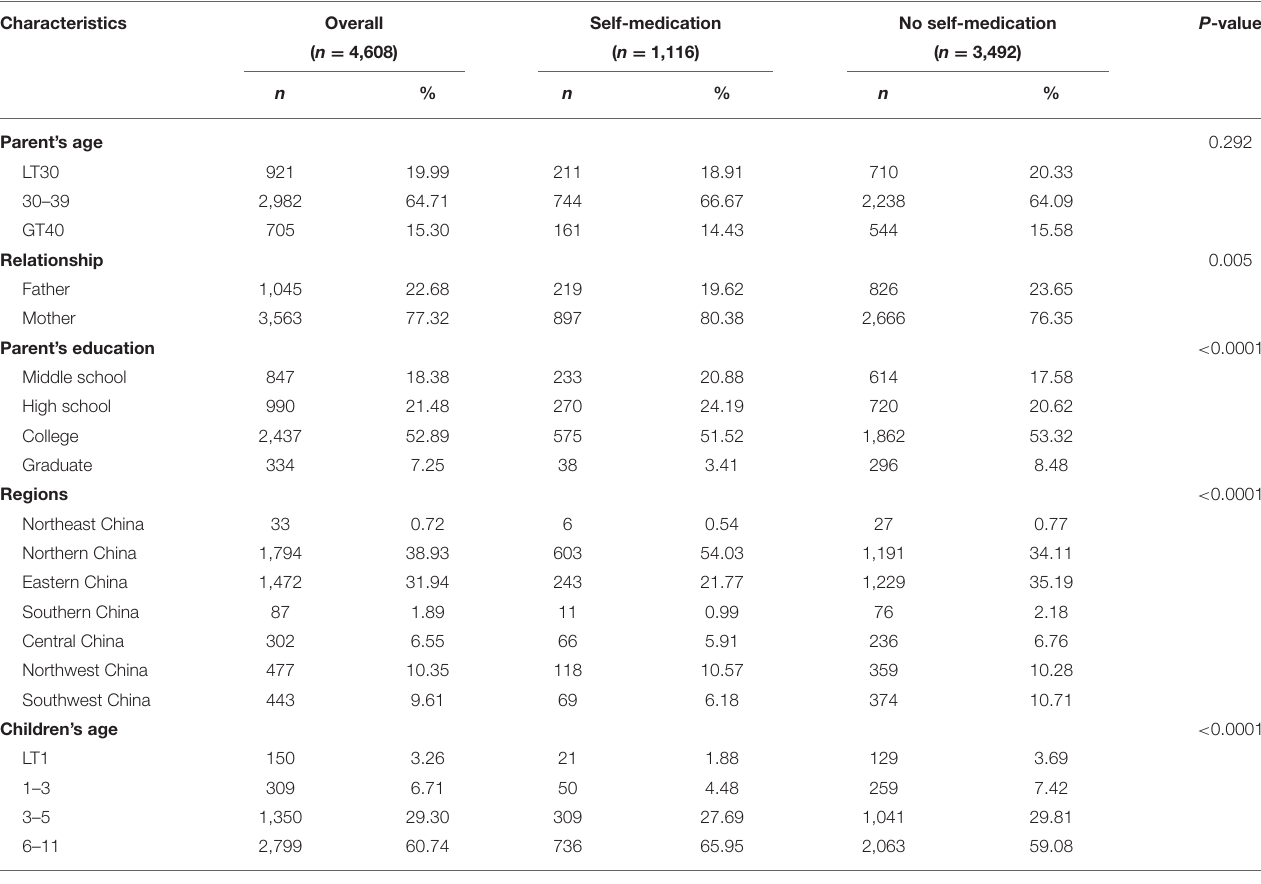
TABLE 1 | Characteristics of respondents.